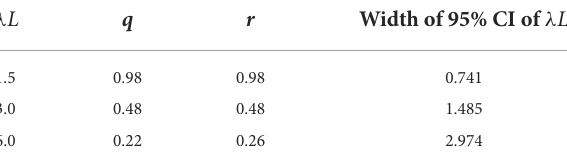
TABLE 4 Combinations of q and r resulted in the narrowest 95% CI of λ L . λ L